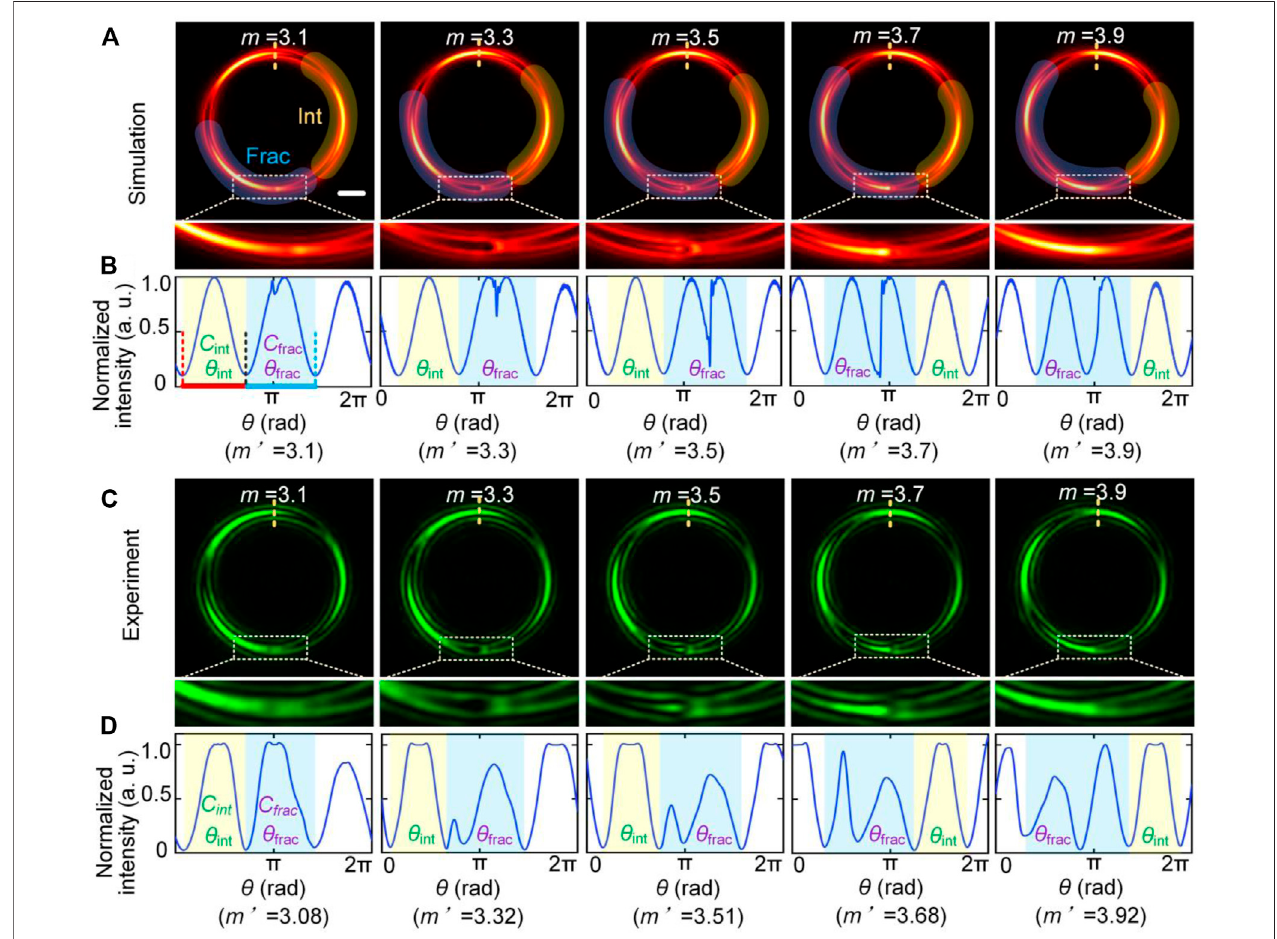
FIGURE 3 | Results for determining the fractional PGP. (A) are the evolution of the interference patterns of ring-shaped Beams with m = 3.1, 3.3, 3.5, 3.7 and 3.9. (B) Azimuthal intensity pro fi les of the interference patterns in (A) . (C,D) are the corresponding experiment results. Scale bar: 100 μ m.